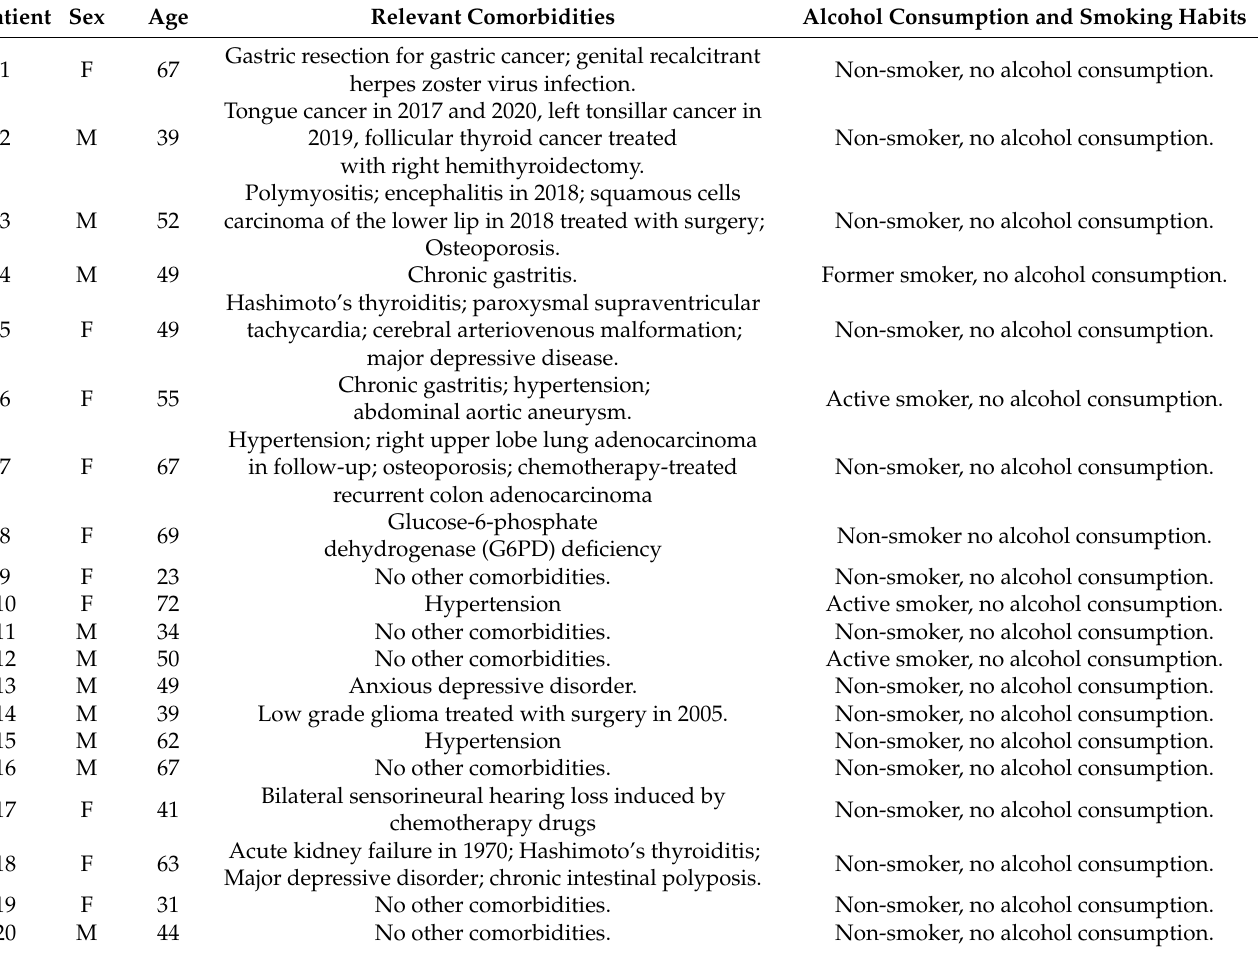
Table 1. Demographic and clinical data.